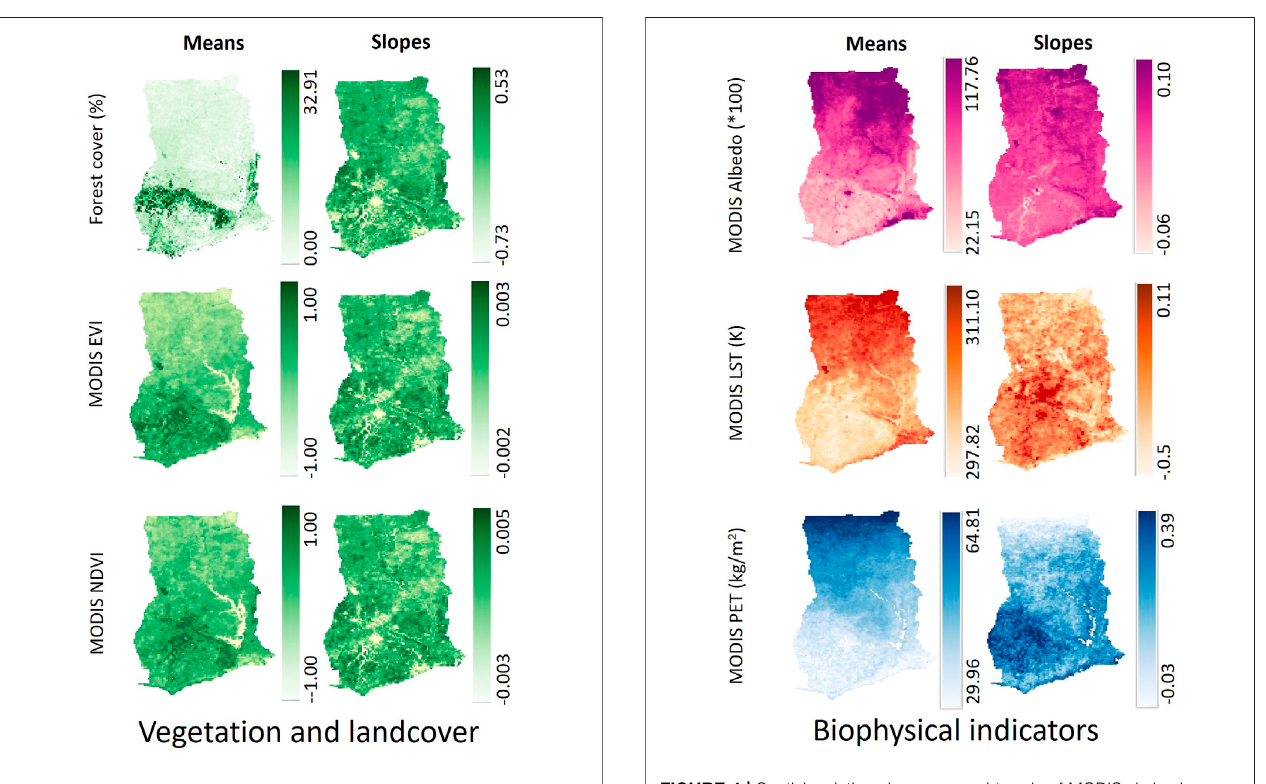
FIGURE 3 | Spatial variations in mean and trends in MODIS-derived and forest cover. Data sources are presented in Table 1 .